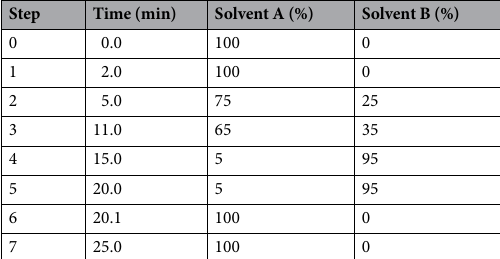
Table 5. Gradient programme for LC-MS